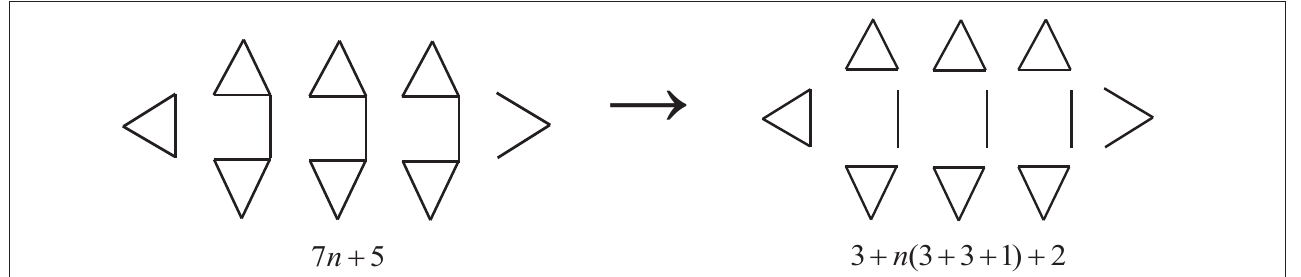
FIGURE 8: Two different formats of Terry’s initial visualisation